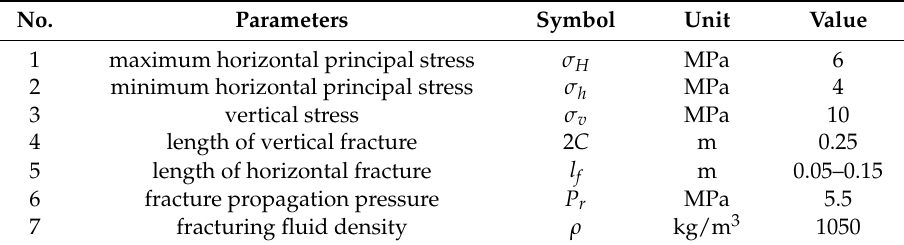
Table 2. T-type fracture model trial results.